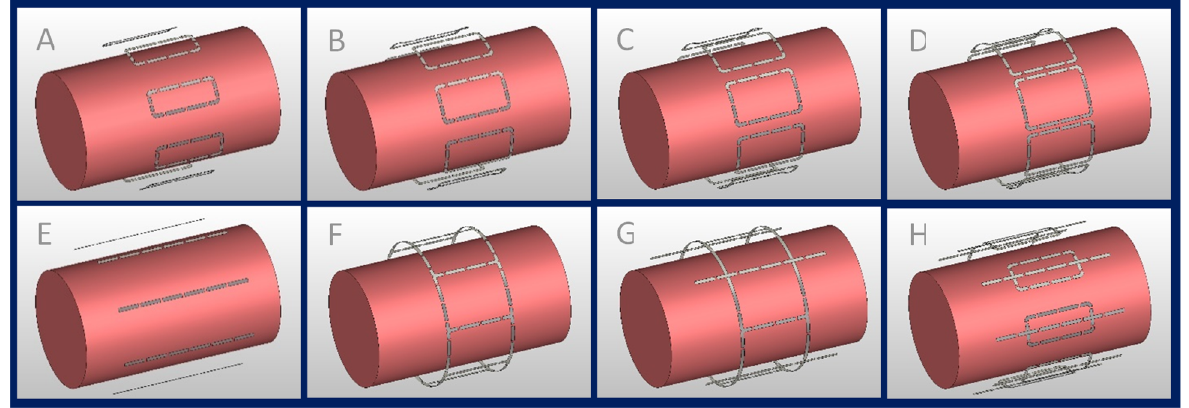
Figure 1. Eight-channel RF transceiver array configurations examined in the EMF simulations; ( A – D ) eight loop elements with L = 100 mm and W ≈ 41 mm, 52 mm, 62 mm, and 72 mm, ( E ) eight fractionated dipoles (L = 200 mm), ( F ) degenerate birdcage with eight rungs (L = 100 mm, D = 210 mm), ( G ) hybrid birdcage with four rungs (L = 100 mm, D = 210 mm) and four dipoles (L = 200 mm), and ( H ) loop–dipole array (L_loop = 100 mm, W_loop ≈ 41 mm, L_dipole = 200 mm). All RF transceivers were placed equidistantly around a cylindrical phantom (L = 300 mm, D = 170 mm) mimicking the electrical properties of muscle tissue 𝜀 (cid:3045) = 58.24, 𝜎 = 0.769 (S m⁄ ) at 297.2 MHz. The RF transceiver arrays were placed 20 mm away from the phantom and shielded at 30 mm.